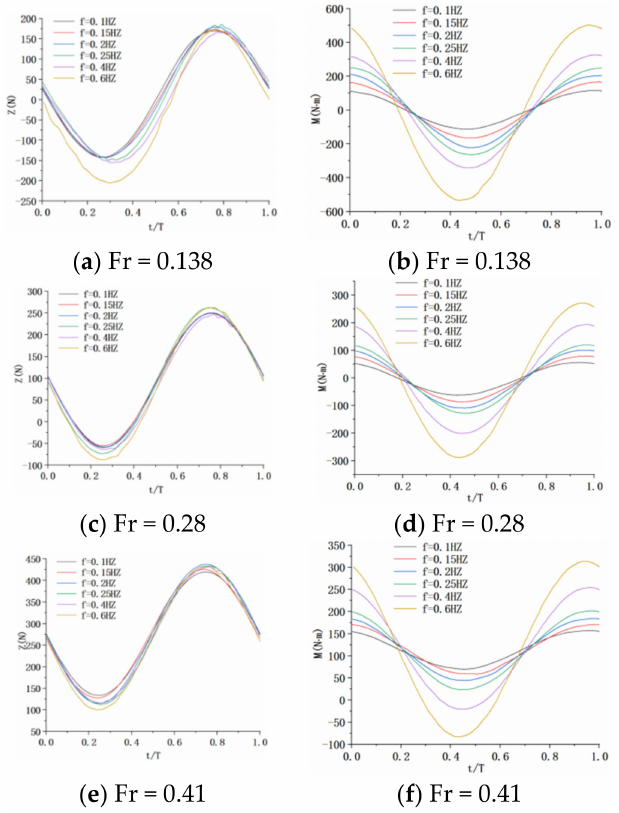
Figure 9. The time-history curves of the vertical force and pitch